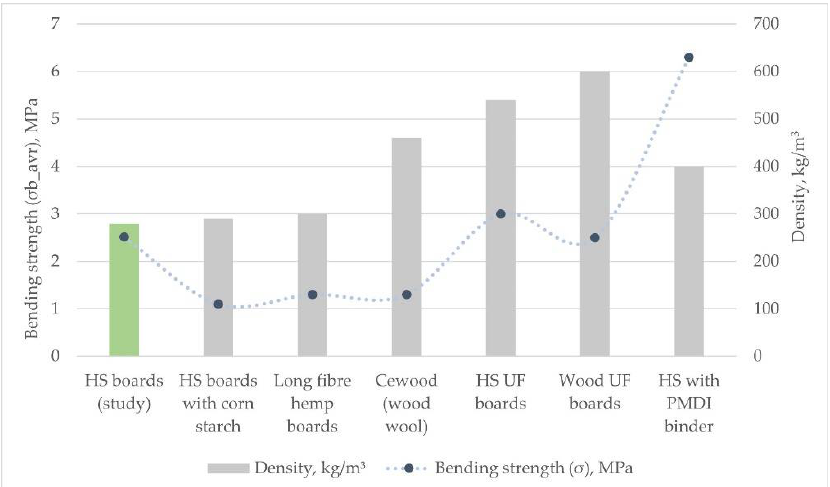
Figure 9. Bending strength comparison of hemp board samples produced in the study to other materials consisting of hemp or wood particles [21,27,33,45,48,63].